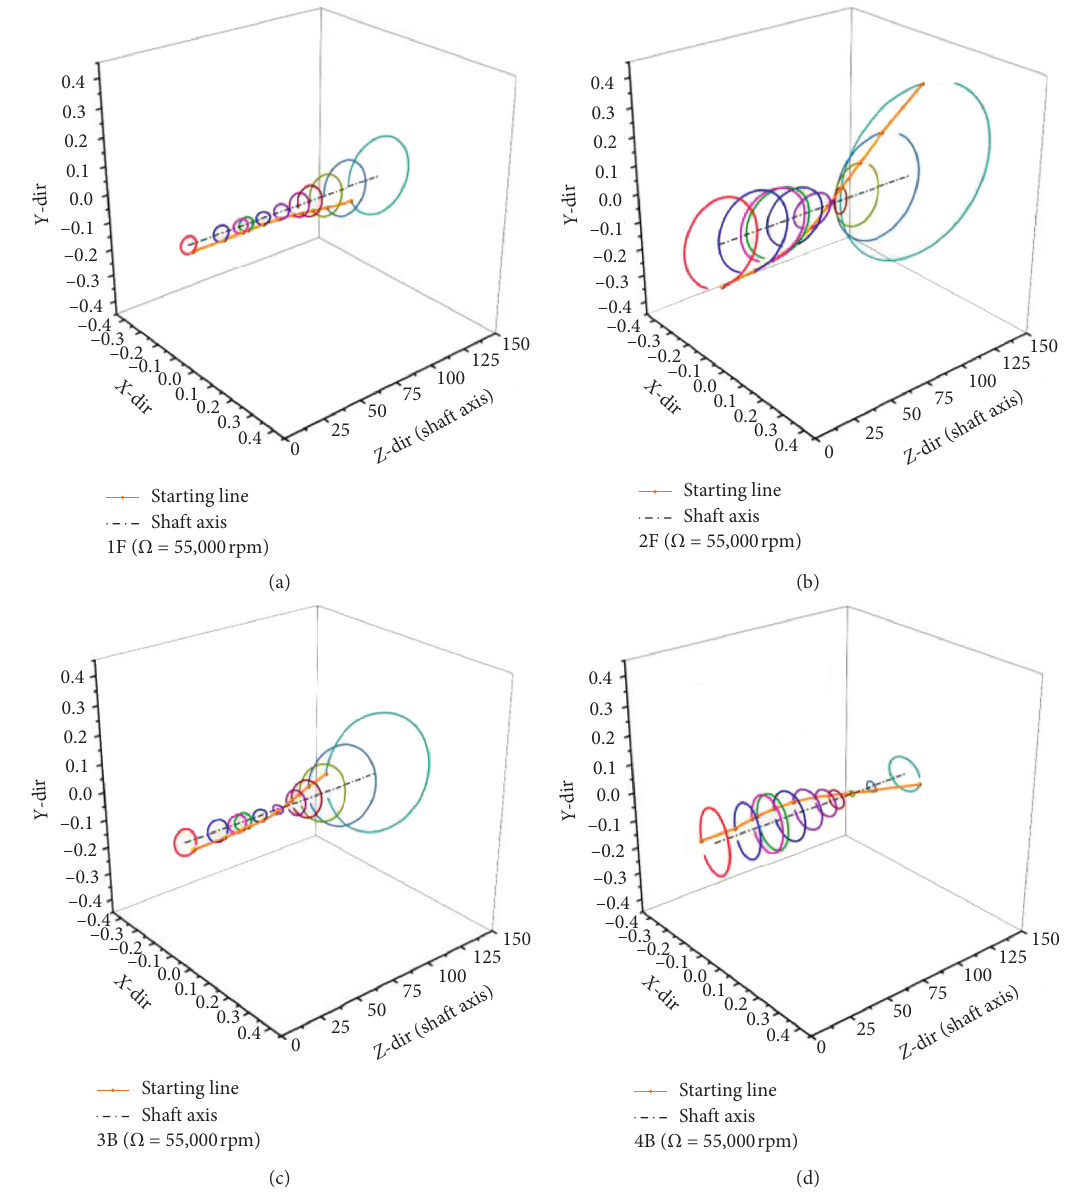
Figure 17: Mode shapes at 55,000rpm (SLS 1). (a) Mode 1F. (b) Mode 2F. (c) Mode 3B. (d) Mode frequency of case 2 shifted to the left, making the change black (red) number in Figure 20. Because the steering of response amplitude more obvious. The response mode is dominant in the response diagram, the critical value at the peak of the 6F and 6B modes decreased from speeds Ω and Ω in case 1 (case 2) 1F and 2F modes cr1 cr2 0.147 mm to 0.014 mm, and that at the peak of the are not shown in the diagram and followed a phenom- 20F and 20B modes decreased from 0.036 mm to enon similar to that reported by Chouksey and Roy 0.0037 mm. [29, 30]. Because of the effect of temperature, the steering